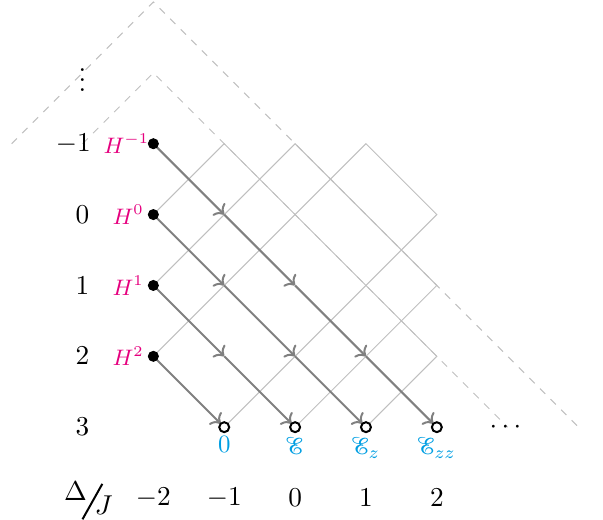
Figure 1 . Celestial conformal dimensions and spins of the graviton modes giving rise to a w 1+ ∞ symmetry (magenta), and modes in the matter sector we expect them to couple to (cyan). The spectrum of these operators are related by 2D light transform. For reference, the ‘celestial diamonds’ are superimposed in